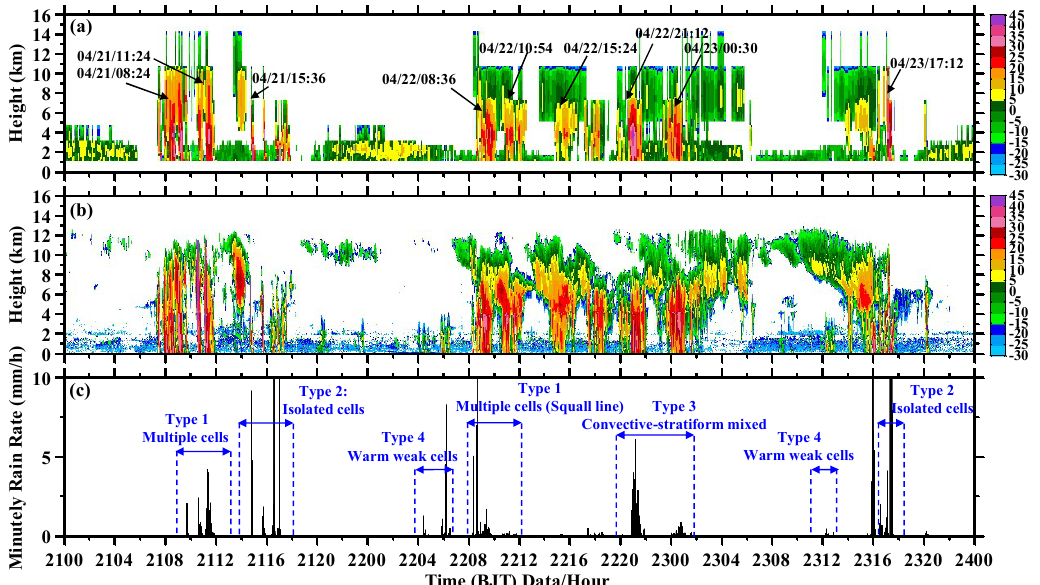
Figure 4. Overall time–height cross-sections of the cloud–precipitation that happened over the Longmen site on 21–23 April 2016: ( a ) S-band radar reflectivity, ( b ) MMCR reflectivity, and ( c ) rain rate measured by Parsivel on the ground.